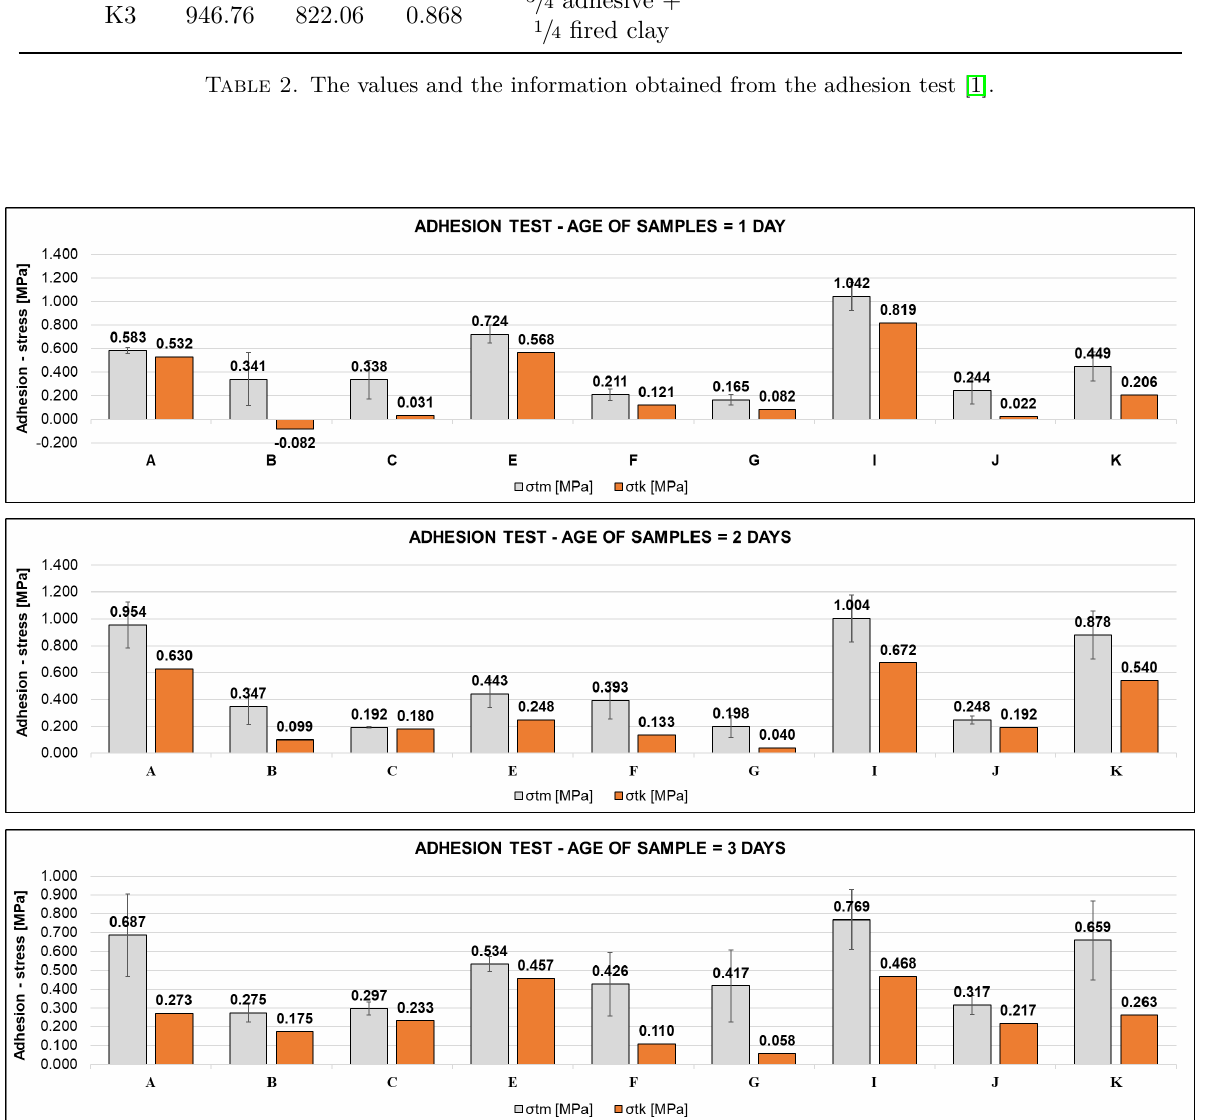
Figure 8. Summary of results from the adhesion test at the age of the samples one, two and three days